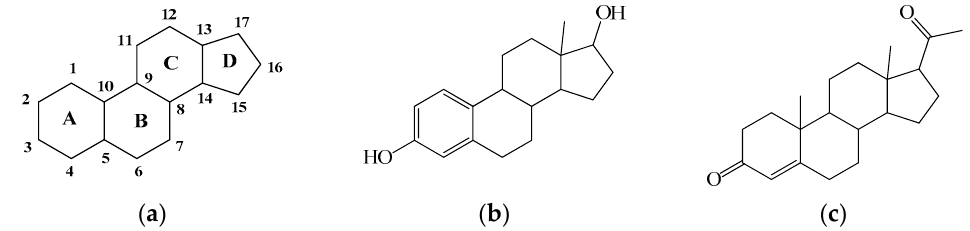
Figure 1. Steroid molecules. ( a ) Steroid configuration. ( b ) Estradiol, E2. ( c ) Progesteron, P4.